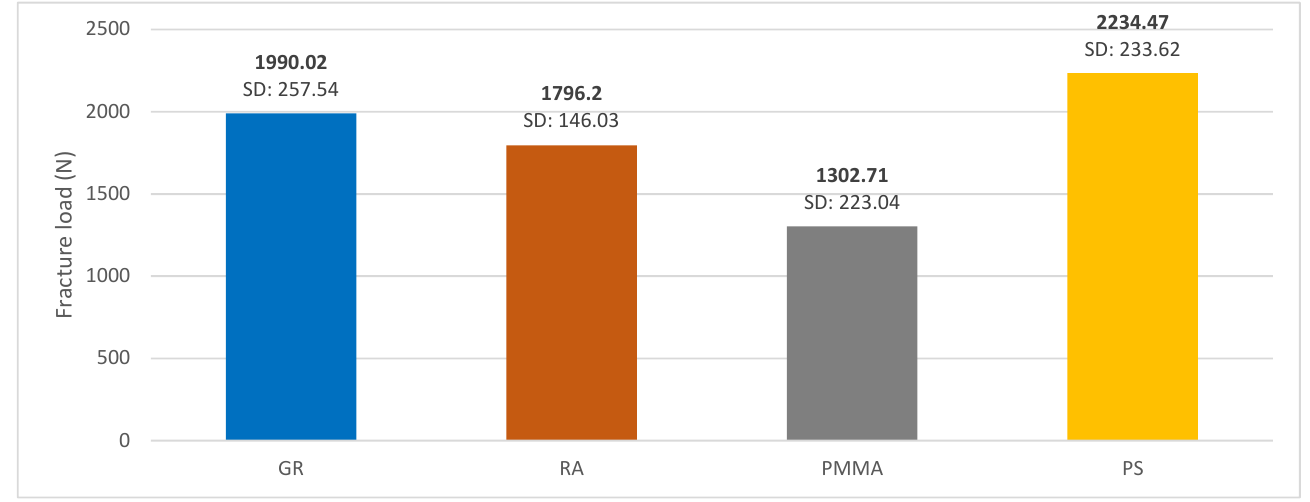
Figure 4. Mean fracture toughness graph of GRA, RA, PMMA and PS materials.